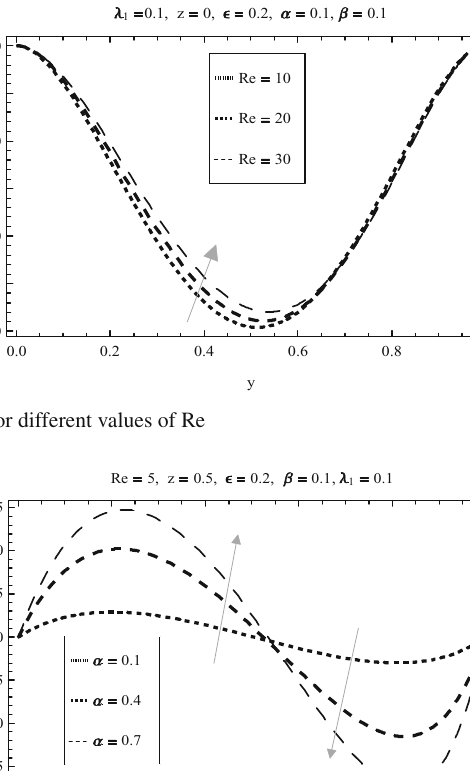
Fig. 8 Velocity component v along y for different values of λ 1